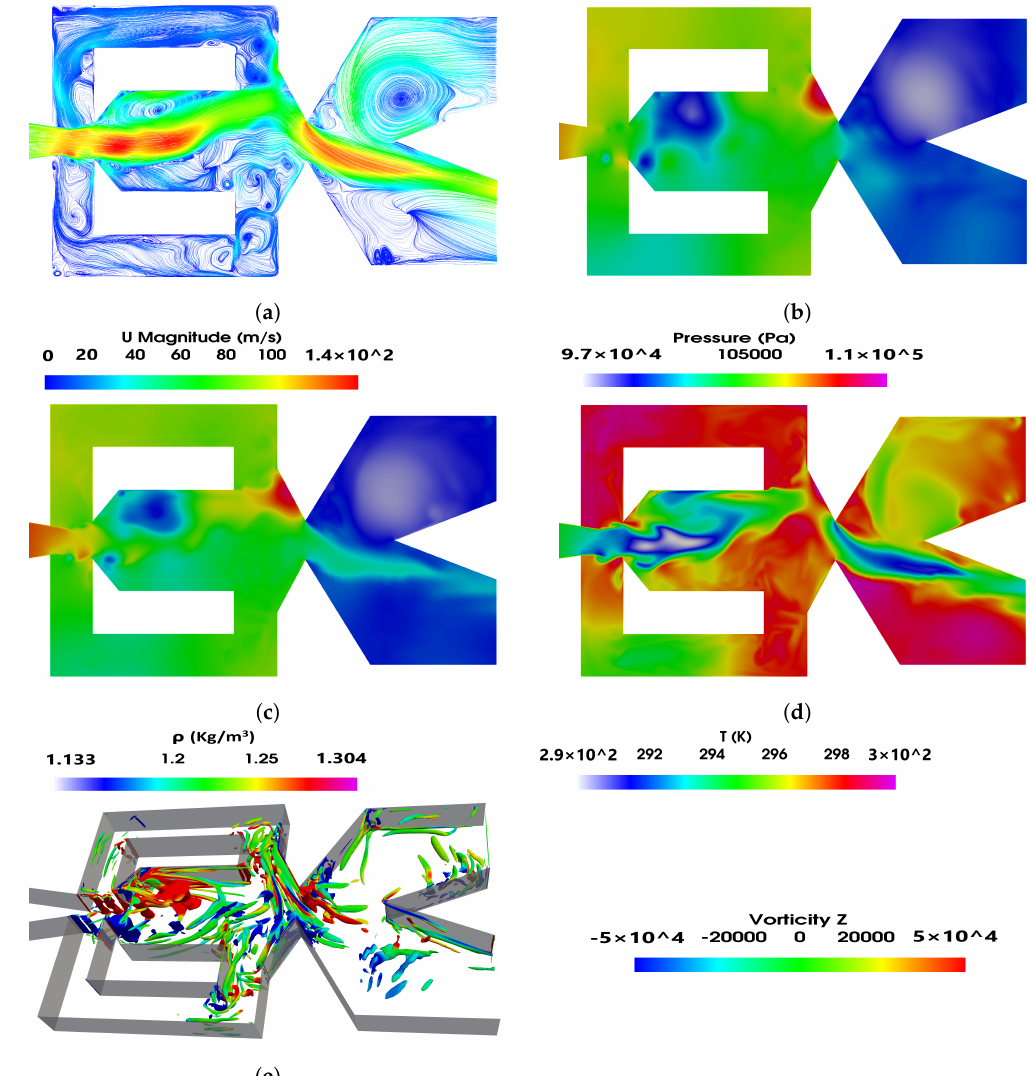
Figure 7. Mixing chamber instant velocity field ( a ), pressure distribution ( b ), density ( c ), temperature ( d ) and ( e ) Q criterion fields. Power nozzle velocity 97 m/s. Baseline